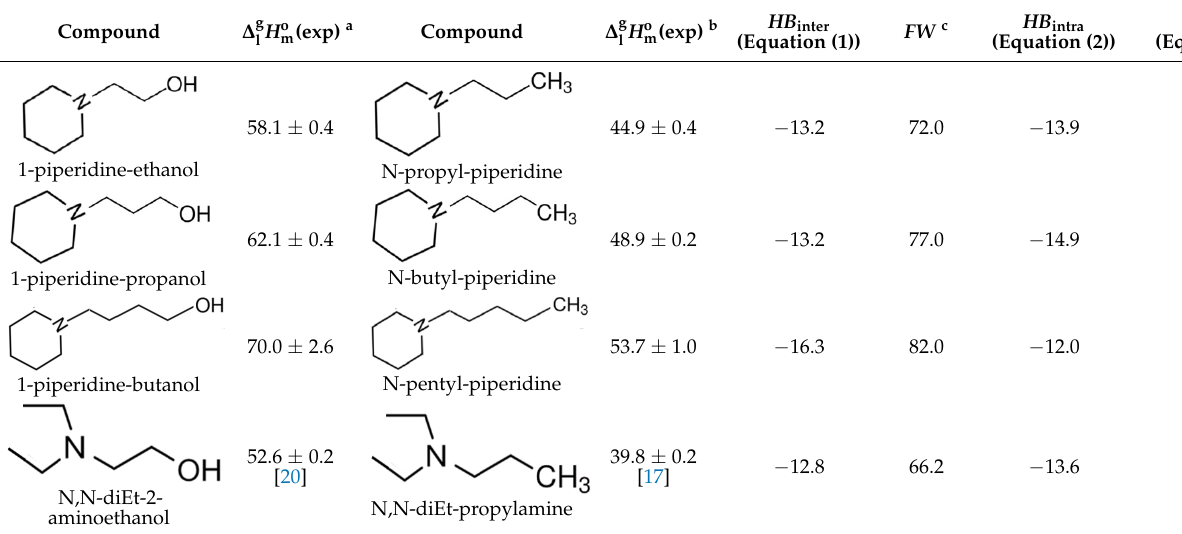
a Experimental data from Table S4. b Experimental data from Table S5. c Enthalpies of vaporisation referred to the frameworks (see text).